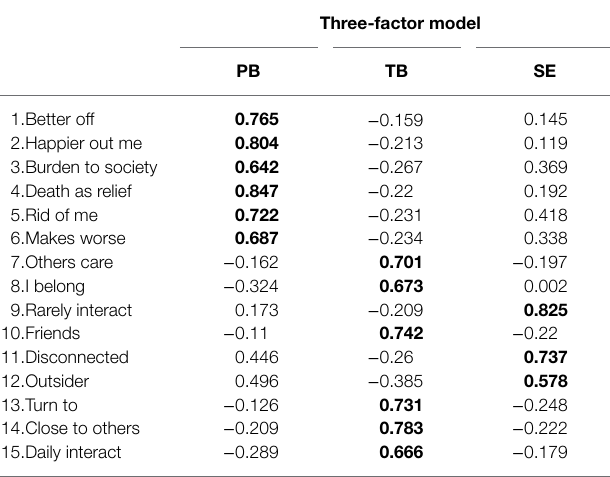
TABLE 3 | Factor structure of the Interpersonal Needs Questionnaire.